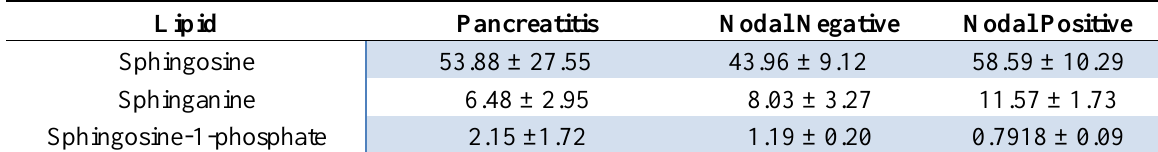
Table 1. Pancreatic Tissue Long-chain Bases (pmol/mg protein).